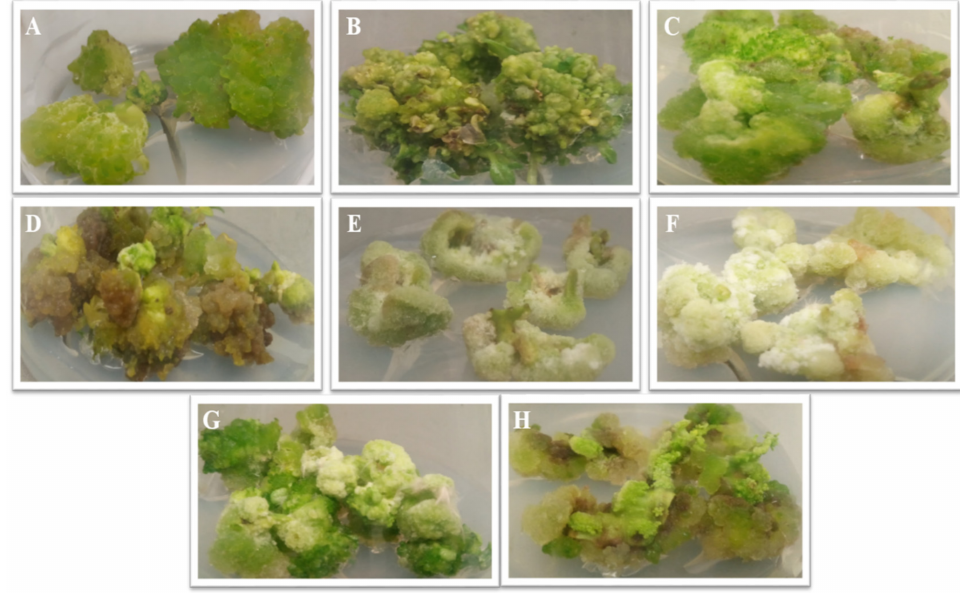
Figure 1. Callus culture treatment under various PGR concentrations, callus morphology, and biomass from leaf explant after 30 days of inoculation: ( A ) 5 mg/L TDZ; ( B ) 2.5 mg/L TDZ; ( C ) 5 mg/L TDZ + 1 mg/L NAA; ( D ) 10 mg/L BAP; ( E ) 10 mg/L NAA; ( F ) 2.5 mg/L NAA; ( G ) 2.5 mg/L TDZ + 1 mg/L NAA; ( H ) 5 mg/L